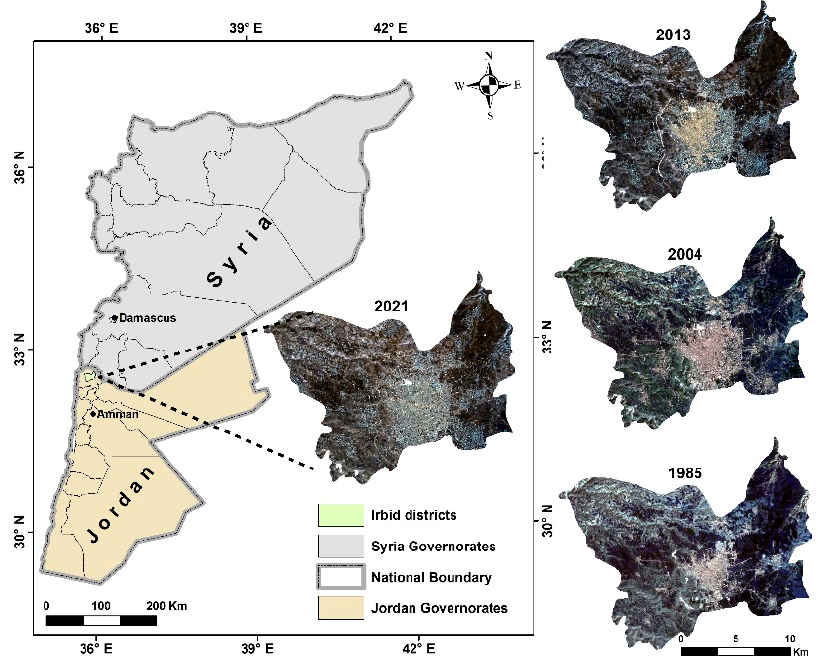
Figure 1. Location map of Irbid District and True Color Composite Images Landsat-5 (1985 and 2004) and Landsat-8 (2013 and